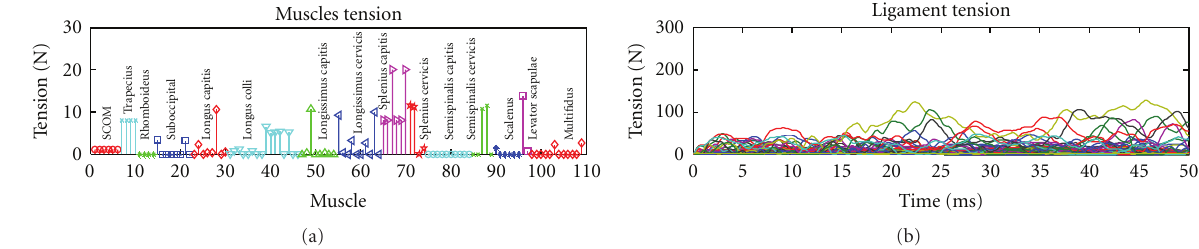
Figure 11: Results obtained after one run of the GA optimization search. (a) Muscle stationary tension values. (b) Tension in ligaments as a function of time. Oscillations are still in place, yet the total displacements in the di ff erent bodies in the complex are